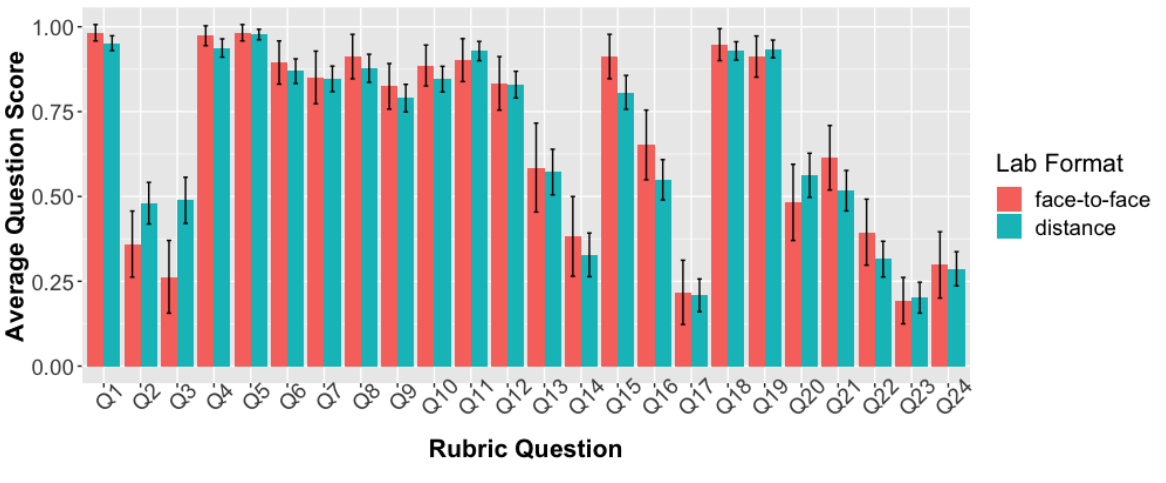
Figure 3 . Average scores obtained with the project grading tool. The error bars show 95% confidence